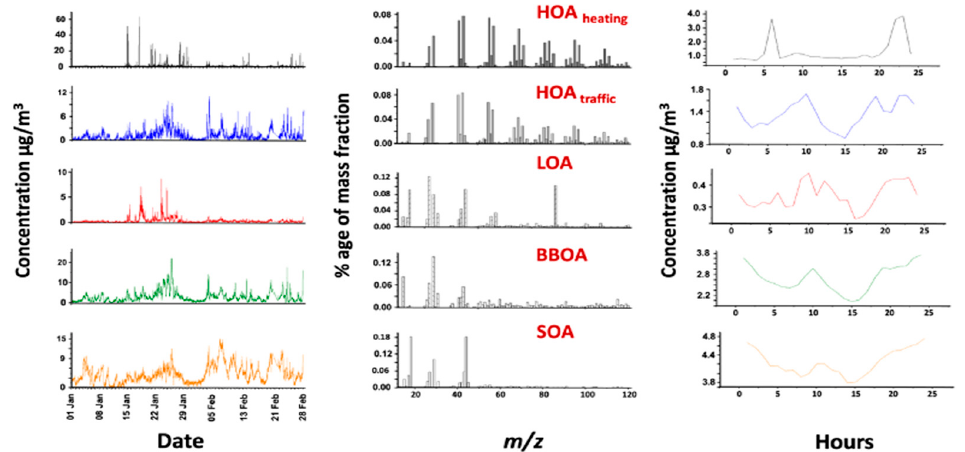
Figure 5. Mass spectra of the five factors from the PMF calculation. The time series ( left ), mass spectra ( middle ), and diurnal patterns ( right ) of the five OA factors determined on the basis of the PMF analysis.